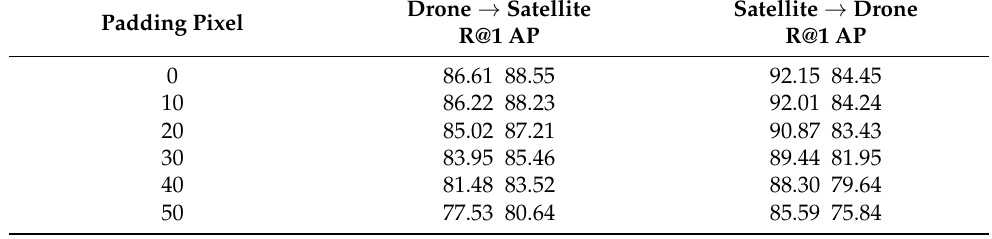
Table 4. Results of ablation experiments of shifting query images during inference. Table 5. Results of ablation experiments of using drone images with different distance to geo- graphic target to conduct retrieval. “All” stands for using all drone-views query images.